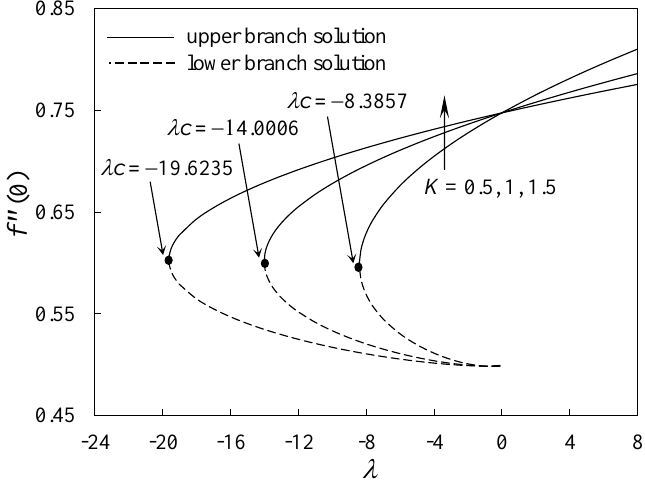
Figure 8. Variation of f (cid:48)(cid:48) ( 0 ) with λ for several values of K for Cu-water nanofluid.